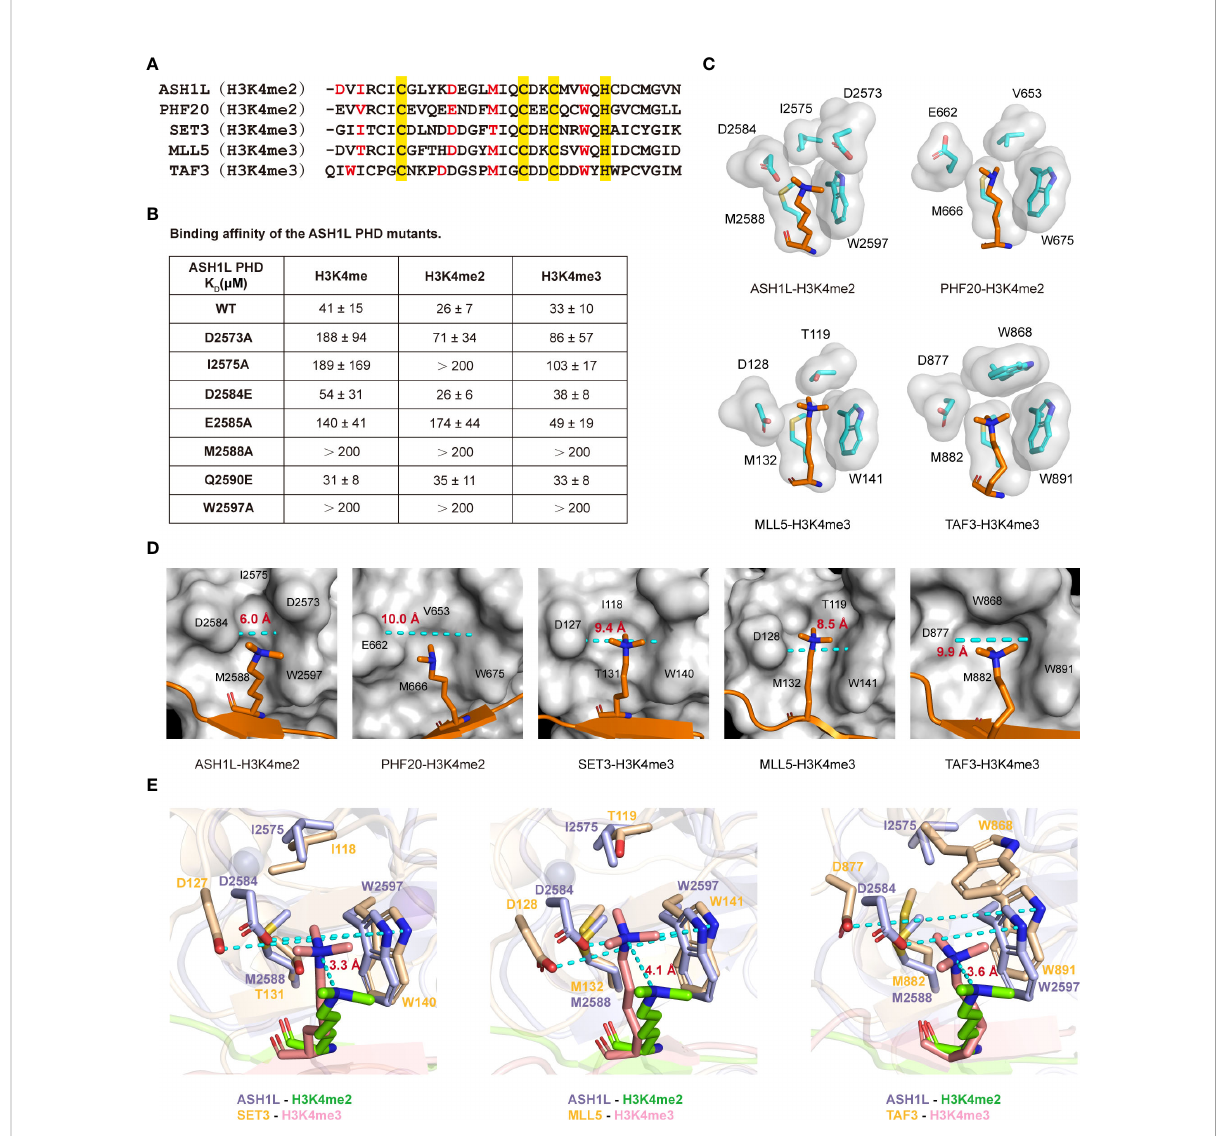
FIGURE 3 Molecular basis of the ASH1L PHD fi nger for non-selective recognition of methylated H3K4. (A) Alignment of amino acid sequences of different PHD fi ngers. The H3K4me2 binding site residues of ASH1L and PHF20, as well as the H3K4me3 binding site residues of SET3, MLL5, and TAF3, are colored red. The conservative skeleton amino acids are colored yellow. The following PDB structures were used in this fi gure: 5tbn (PHF20), 4l58 (MLL5), 5tdw (SET3), and 2k17 (TAF3). (B) Binding af fi nities of the mutated ASH1L PHD fi nger with the indicated histone peptides are measured by ITC. (C) The binding pockets of the different PHD fi ngers are illustrated by showing the side chains (cyan stick and surface representation) that surround the methylated H3K4 ligand residue (orange stick). (D) Surface plots of ASH1L, PHF20, SET3, MLL5, and TAF3 PHD fi nger binding with H3K4me2 or H3K4me3 peptide (orange). The side chain of K4 is in a stick mode, and the other part of H3 peptide is in a cartoon mode. The distance between the aspartic side chain and the tryptophan aromatic ring are measured using Pymol software and labeled. (E) Superimposed H3K4me2 (chartreuse) binding site of ASH1L PHD fi nger (light blue) and H3K4me3 (salmon) binding sites of SET3, MLL5, and TAF3 PHD fi ngers (wheat) are shown. The distance between the methyl-ammonium moiety of K4 in different PHD fi nger structures are measured using Pymol software and